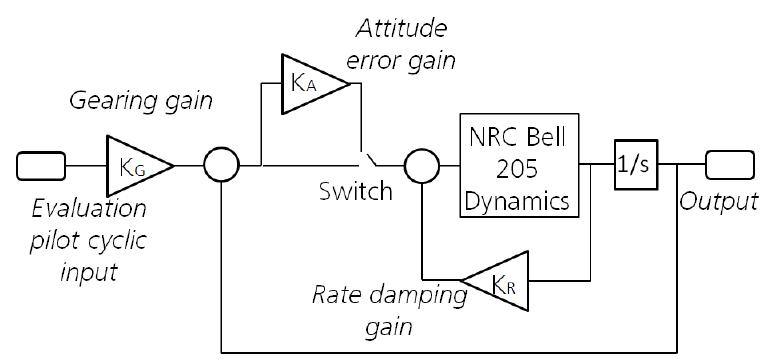
Figure 2. NRC Bell 205 basic simplified control structure.